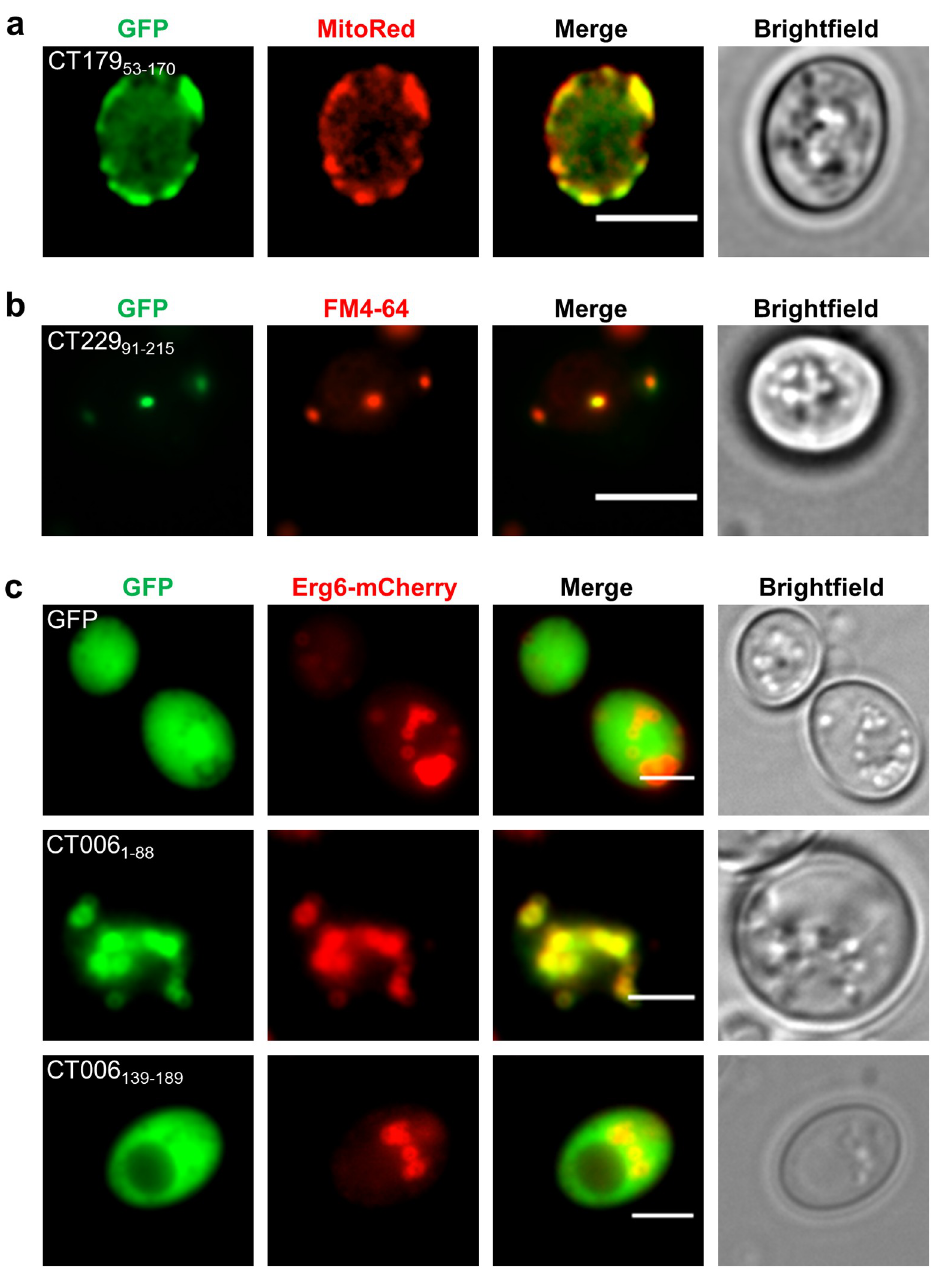
Fig 2. Intracellular localization of C . trachomatis Inc fragments fused to GFP when produced in yeast. S . cerevisiae strains ectopically expressing the genes encoding the indicated fusion proteins were grown in the presence of galactose. Live cells were visualized by fluorescence microscopy, directly or after the indicated staining. The intracellular localization of all Inc-GFP fusion proteins analyzed in this study is summarized in S2 Table. Scale bars, 5 μ m. (a) Yeast strains producing CT179 53-170 -GFP were stained with MitoRed, a mitochondrial probe, indicating that CT179 53-170 - GFP co-localizes with mitochondria. (b) Yeast strains producing CT229 91-215 were incubated with FM4-64 and CT229 91-215 co-localized with FM4-64-stained endosomal compartments. (c) This analysis was performed with yeast strains ectopically co-expressing the genes encoding Erg6-mCherry (protein marker of LDs) and GFP, CT006 1-88 -GFP or CT006 139-189 -GFP and indicates that CT006 1-88 -GFP co-localizes with LDs and CT006 139-189 -GFP is cytosolic.